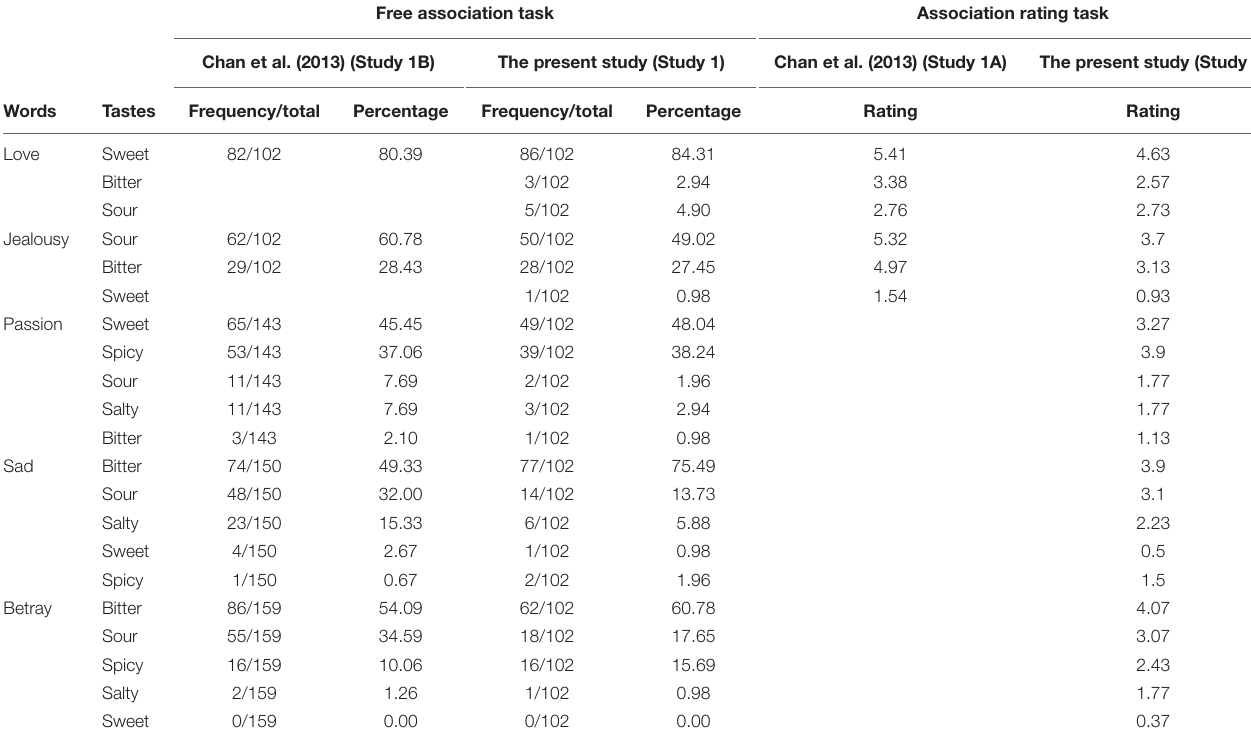
TABLE 6 | Comparison of results from Chan et al. (2013) and the present